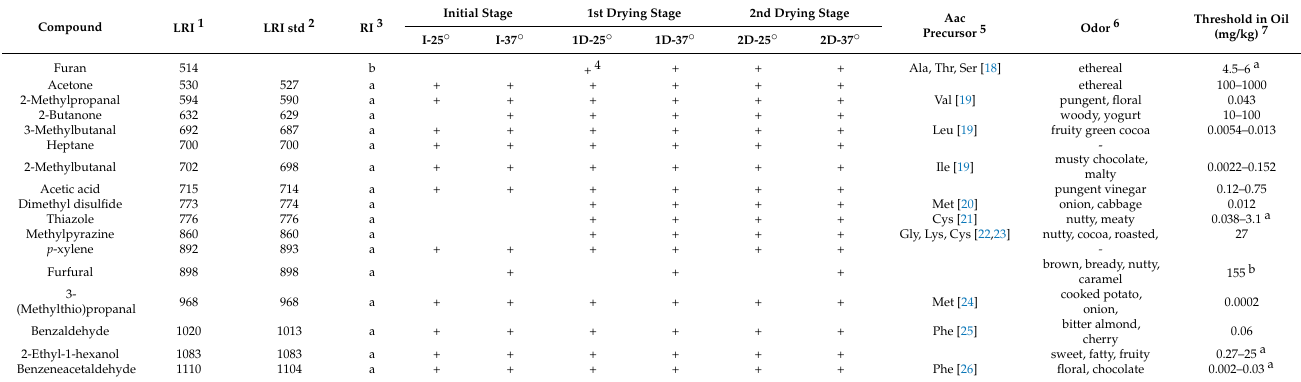
Table 1. Volatile compounds identified in the model